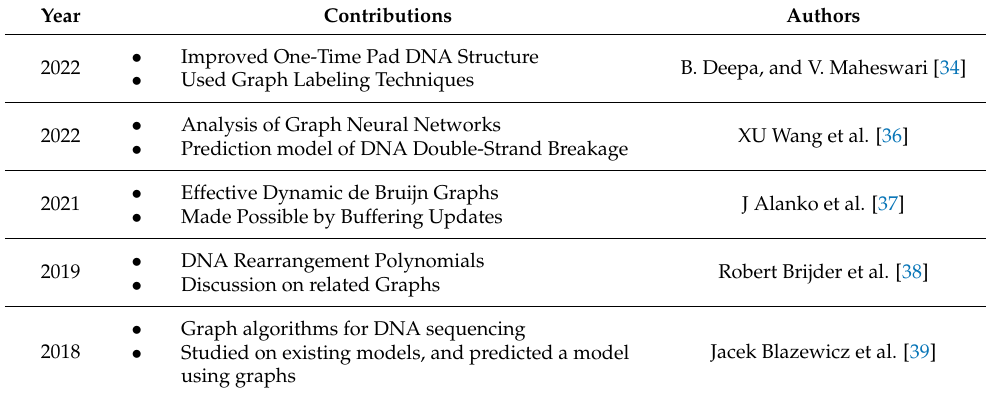
Table 1. Graphs and recent developments in DNA